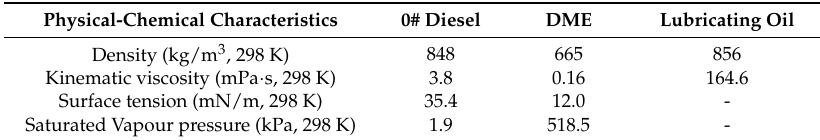
Table 1. Physical-chemical characteristics of 0# diesel, DME and lubricating oil.